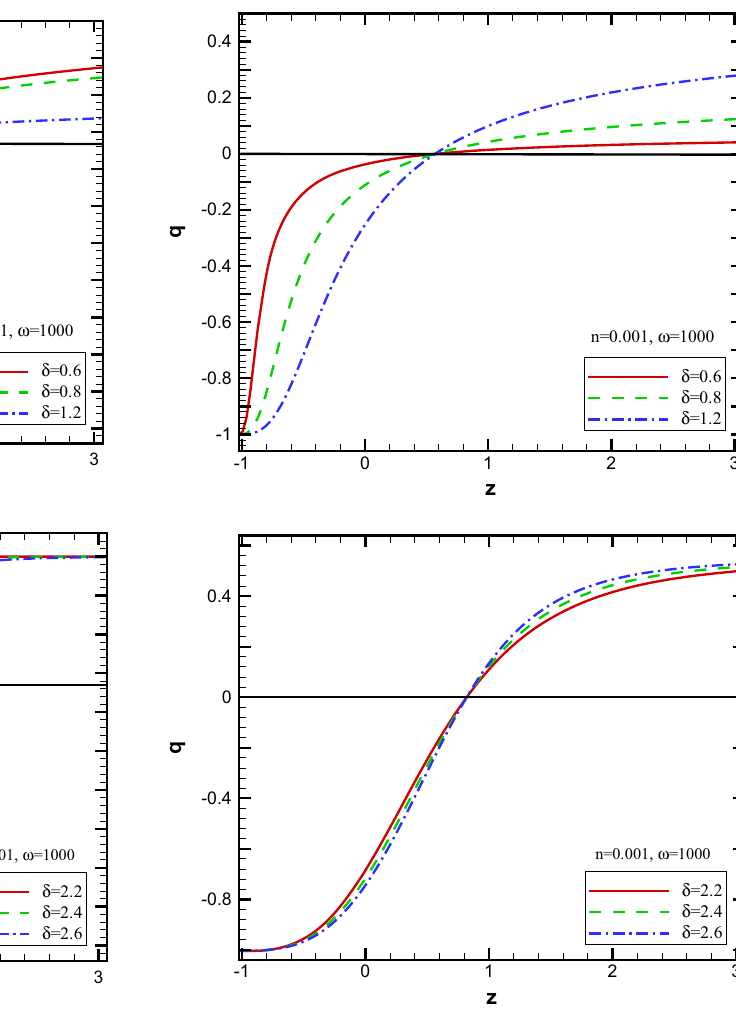
Fig. 2 The evolution of the EoS parameter ω D versus redshift param- eter z for the non-interacting THDE, where the different parameter values (cid:3) k = 0 (upper panel), (cid:3) k 0 = 0 . 1 (lower panel), n = 0 . 001 and ω = 1000 [19] are adopted